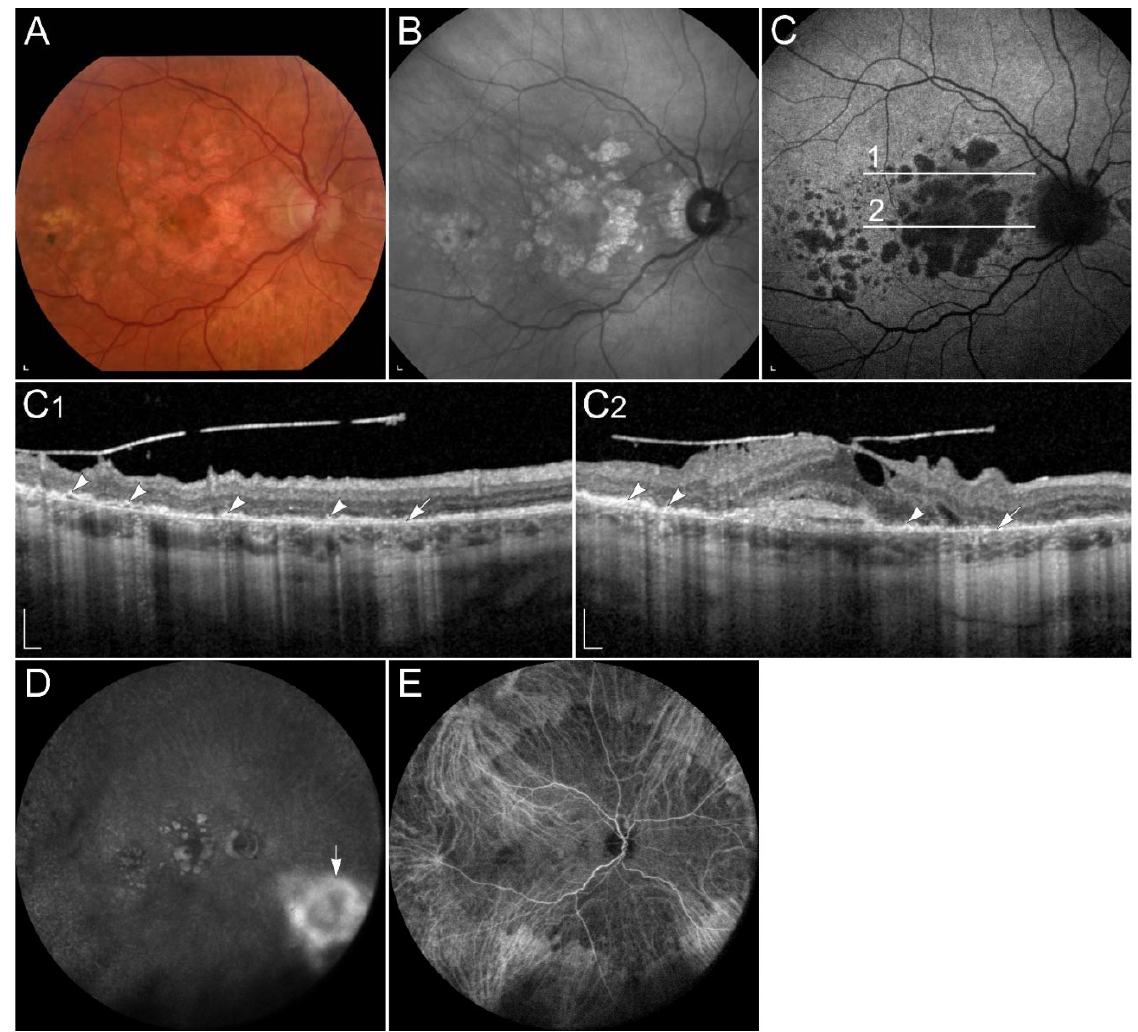
Figure 7. Patient with Sorsby dystrophy due to pathogenic variant p.(Ser170Cys) in TIMP3 . ( A ) Colour fundus image, ( B ) fundus infrared image, and ( C ) FAF image with corresponding ( C1,C2 ) SD-OCT images showing (arrows) geographic atrophy and (arrowheads) subretinal drusen-like deposits. ( D , arrow) Hyperfluorescent area is compatible with choroidal neovascularisation. ( E ) The reduced indocyanine green late-phase angiography fluorescence due to decreased permeability of Bruch’s membrane. Patient’s best corrected Snellen decimal visual acuity was 0.4 on the right eye and 0.6 on the left eye. Scale bars: 200 µ m. Source: Eye Hospital, University Medical Centre